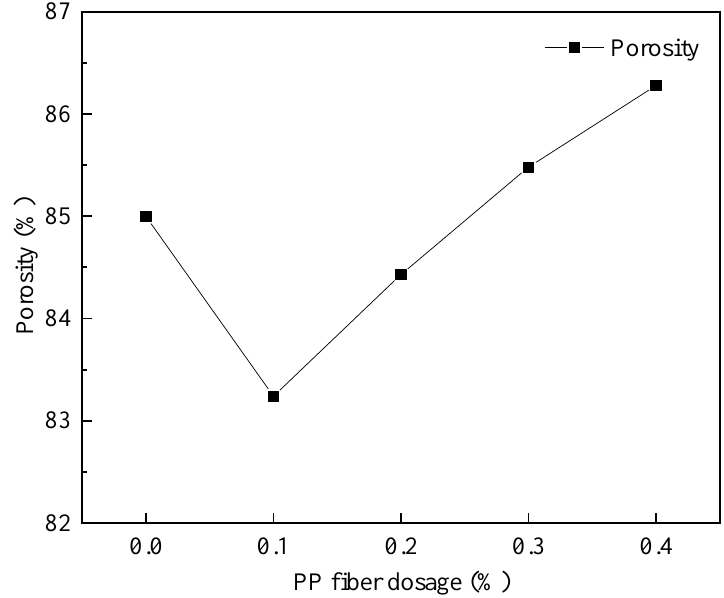
Figure 21. Effect of fiber doping on porosity.